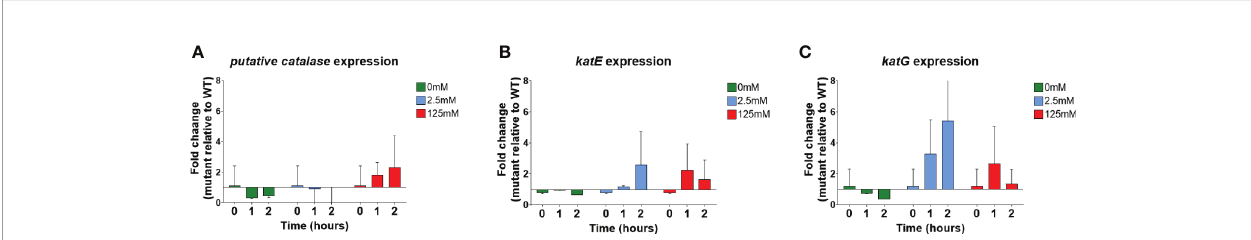
FIGURE 6 | Transcriptional response of catalase genes in WT S. Typhimurium and S. Typhimurium D csgA D wcaM D yihO D bcsE bio fi lms. qPCR measured copy number of (A) putative catalase gene (B) katE or (C) katG transcripts present in bio fi lm cDNA reverse transcribed from total bio fi lm RNA. RNA samples were collected for WT and EPS mutant at each H 2 O 2 concentration from 0-2 hours. The data are expressed as fold-change in EPS mutant relative to the WT as determined by the Livak method (Livak and Schmittgen, 2001). Values >1 indicate increased transcription of the target gene by the mutant compared to WT and values <1 represent a decrease. Bio fi lm RNA was collected and reverse transcribed to cDNA from three independent bio fi lm challenge experiments. Each cDNA sample was analyzed in triplicate by qPCR to determine C T value of each gene and the data represent the mean of three C T values associated with each independent challenge experiment. Error bars indicate SD.